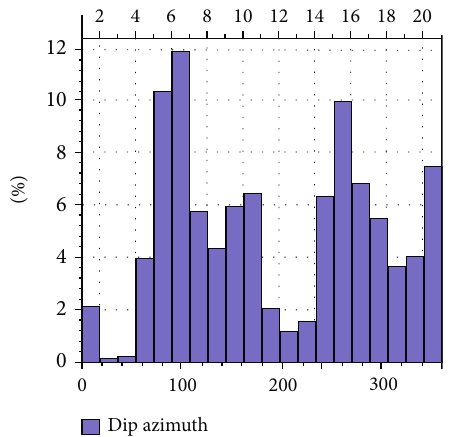
Figure 15: Histogram of fracture azimuth distribution.